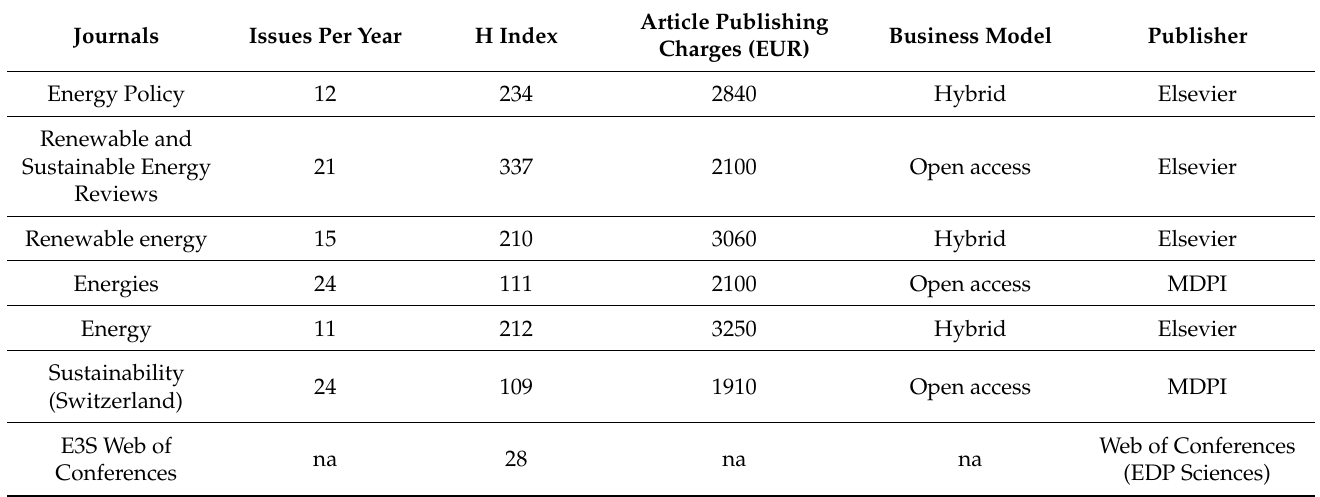
Table 7. Characteristics of